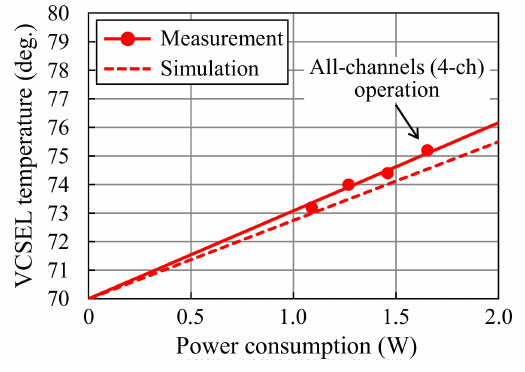
Figure 7. Measured vertical cavity surface emitting laser (VCSEL)